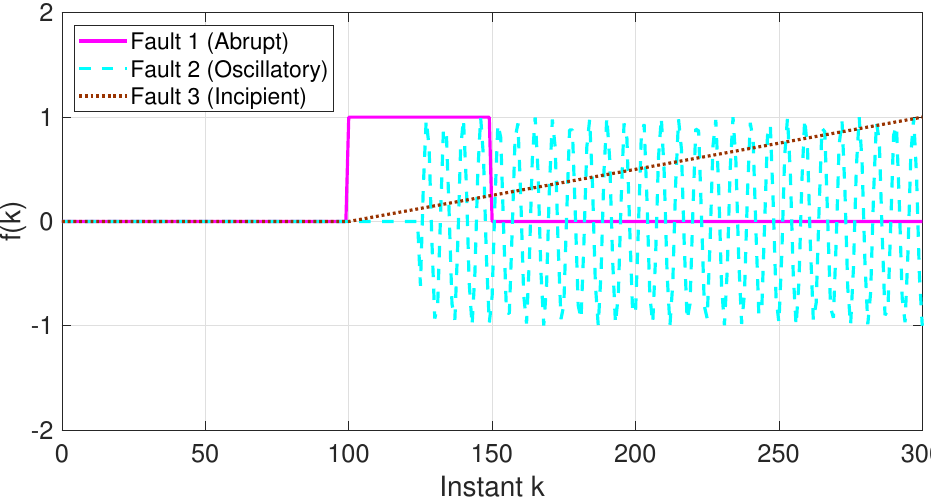
Figure 5. The representation of the three faults that were inflicted in the system during simulations. The magenta curve represents an abrupt fault, the cyan curve denotes an oscillatory fault, and the brown curve is the incipient